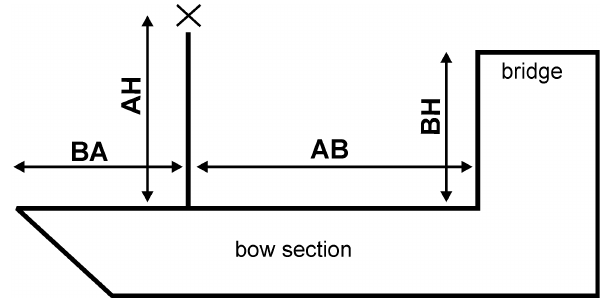
Fig. 4. Illustration is showing the distances of bow tip to anemome- ter location (BA), anemometer to bridge (AB), anemometer height above deck (AH) and bridge height above deck (BH). The cross above the foremast indicates the anemometer